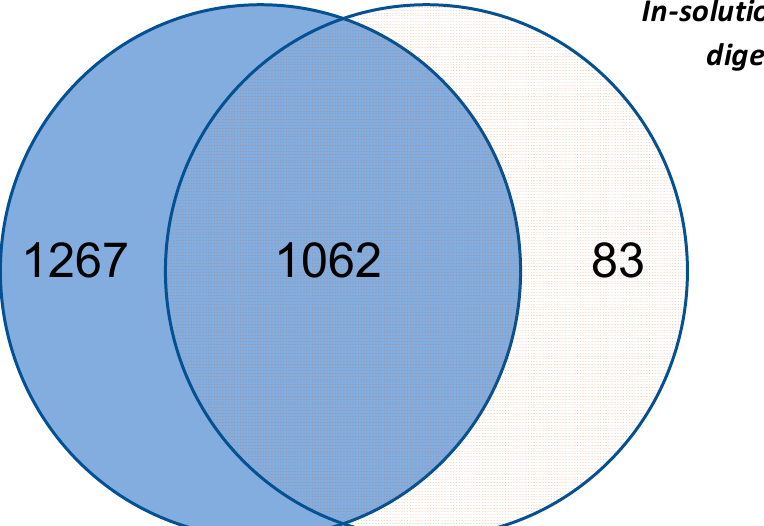
Figure 3. The Venn diagram of the proteins identified in ginseng by in-gel protein digestion or in-solution protein digestion.